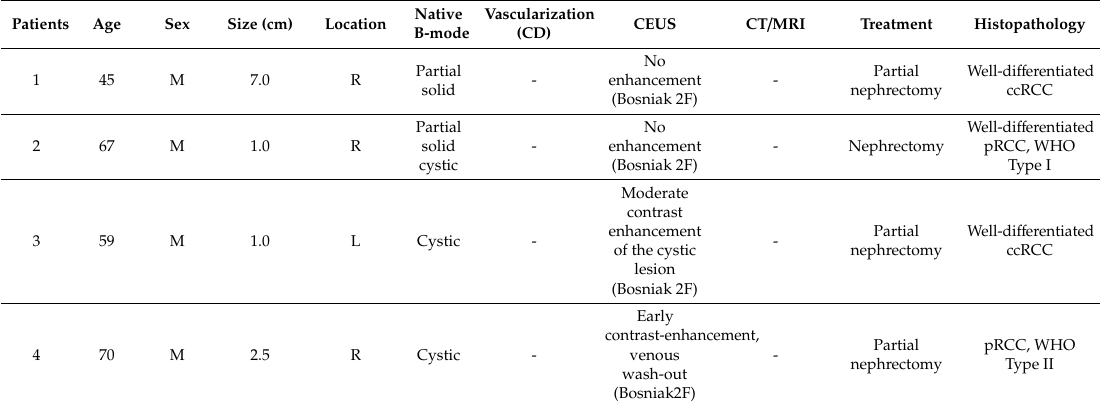
Table 2. Patients with Bosniak 2F lesions who underwent renal surgery without follow-up CEUS. Patients